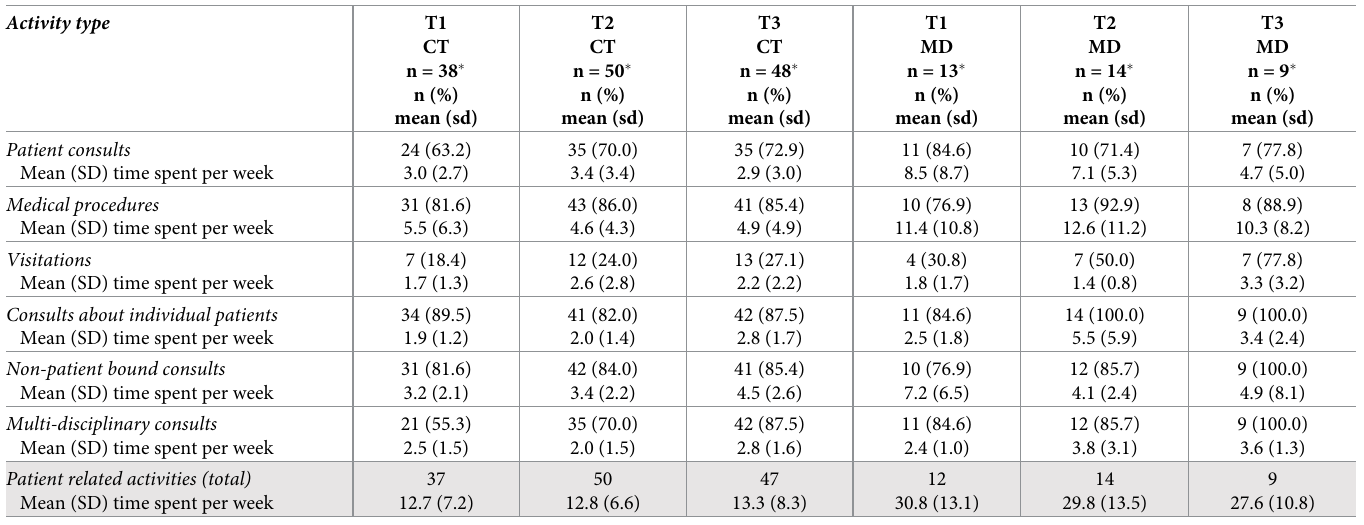
Table 4. Mean time spent on patient related activities.